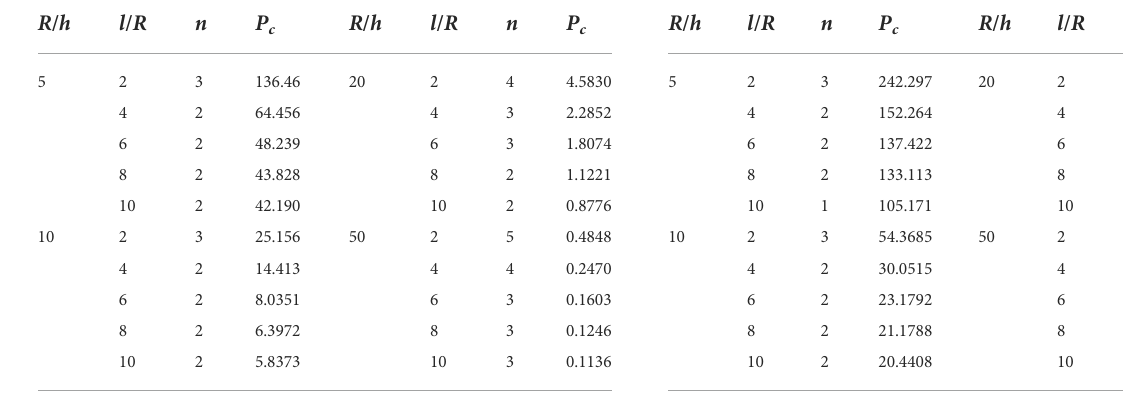
TABLE 6 Critical pressure values with [0/90/0]s con fi guration and Glass/Epoxy composite